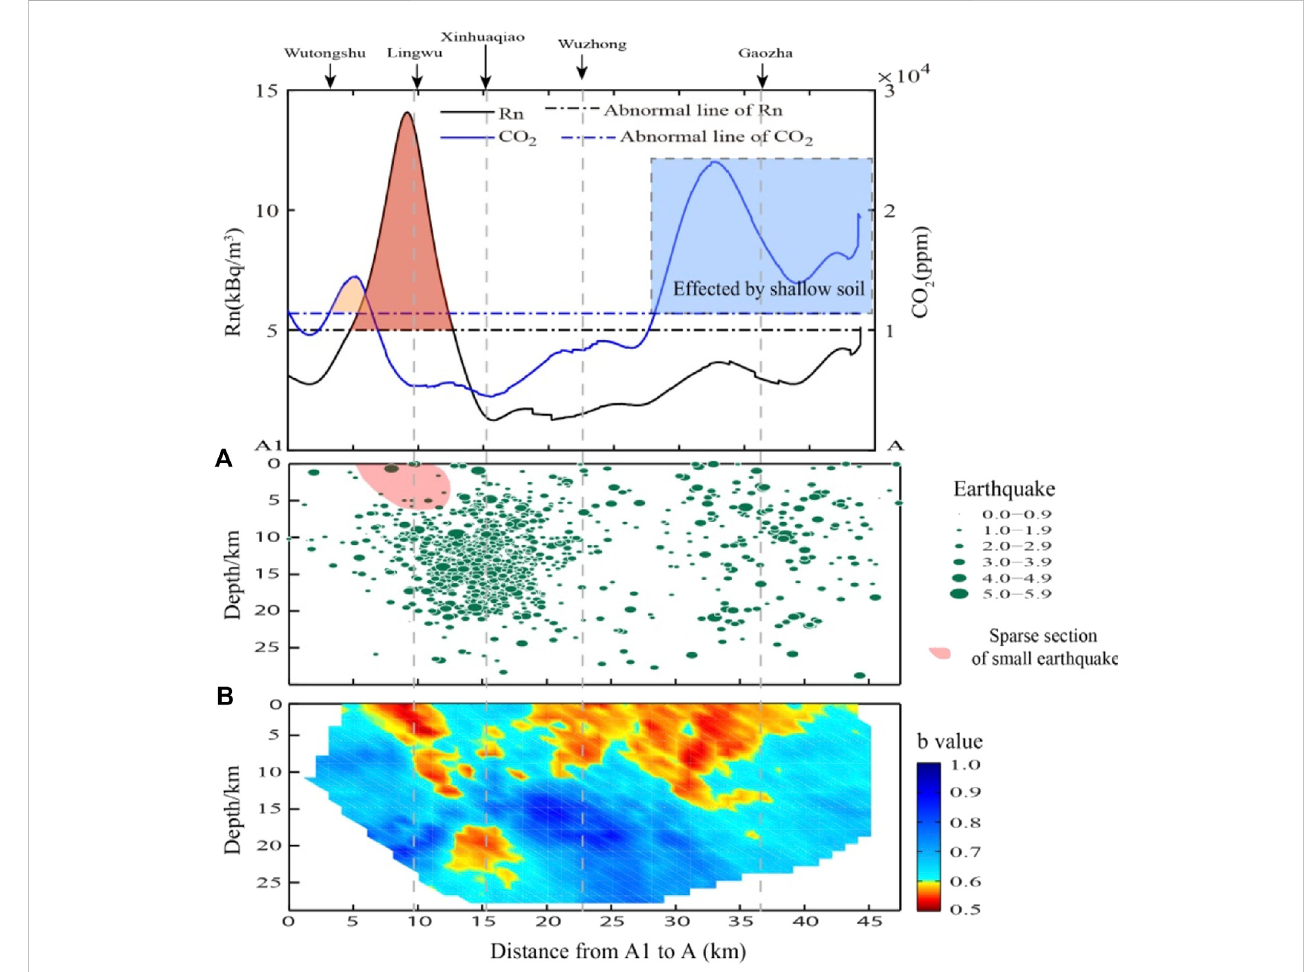
FIGURE 9 Depth pro fi les of (A) gas concentration, (B) earthquake scale, and (C) b-value in the Wuzhong – Lingwu area. The light pink shadow and dark red shadow represent the anomalies of CO2 and Rn above the